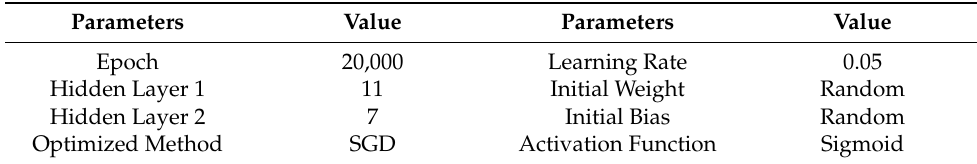
Table 17. Optimized network hyperparameters (CAE-1024).